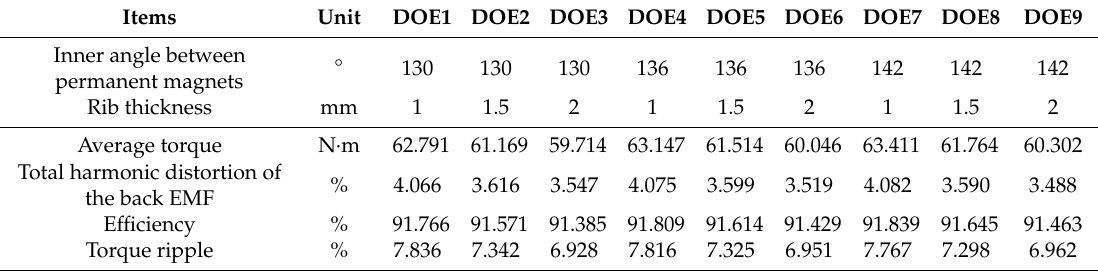
Table 2. DOE results. DOE: design of experiments.